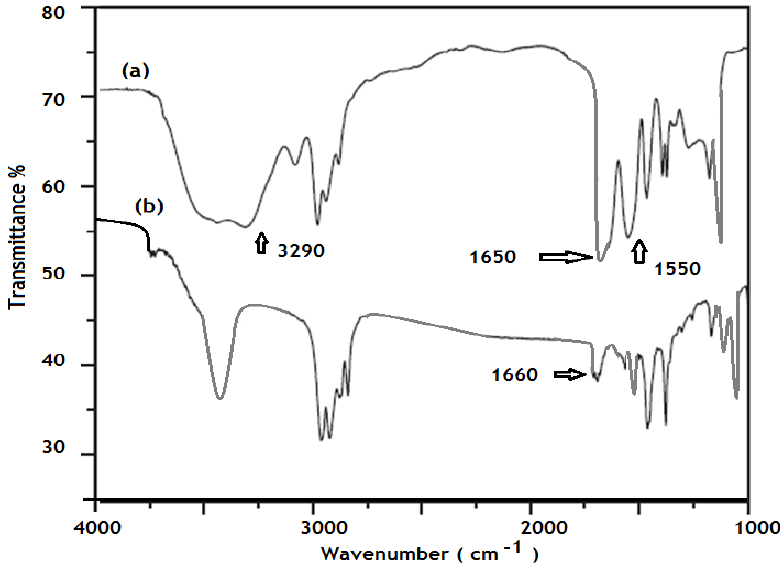
Figure 5. FTIR spectra of ( a ) AMPS/NIPAm nanogel and ( b ) silver AMPS/NIPAm hybrid